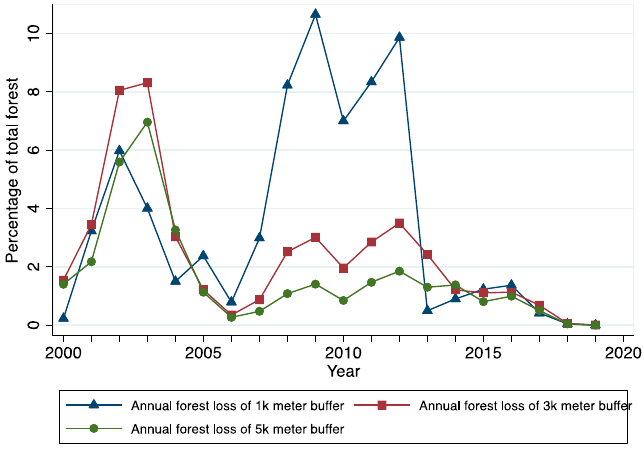
Figure 10. Yearly deforestation rate for Village B in 1000-, 3000-, and 5000-m buffers, 2000–2019.